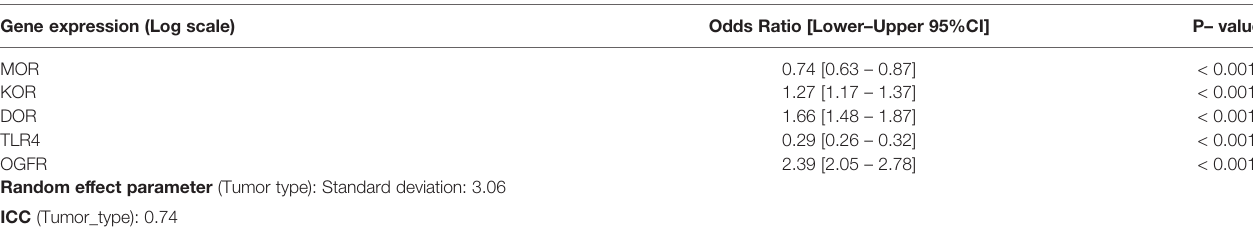
TABLE 2 | The association between opioid receptor gene expression and tumor type. Gene expression (Log